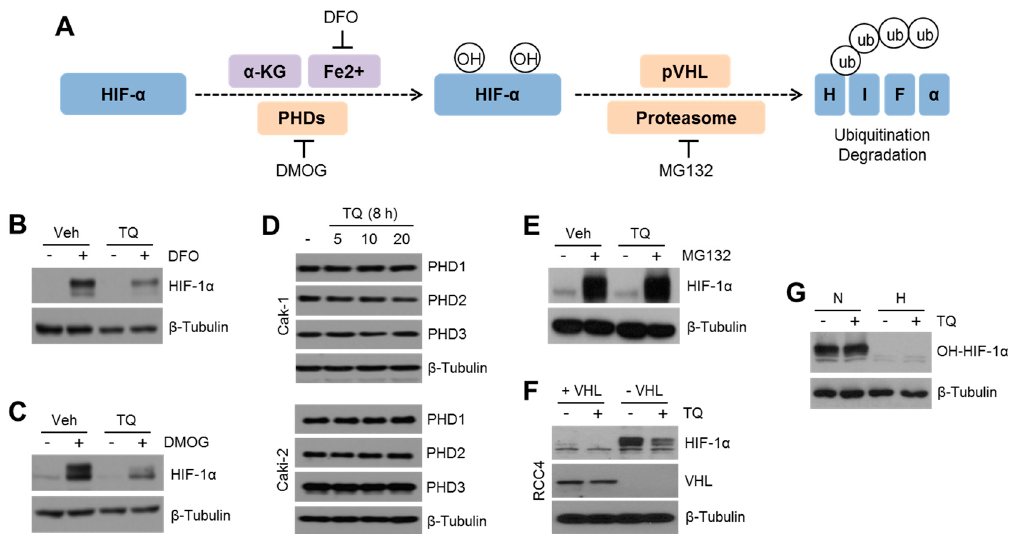
Figure 3. TQ suppresses HIF-1 α via the proteasome-dependent degradation pathway. ( A ) Schematic summary of HIF-1 α hydroxylation and its proteasome-dependent degradation pathway.